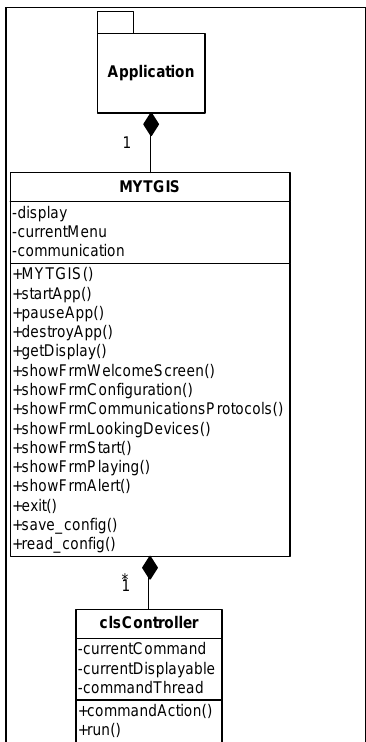
Figure 5. Class diagram of the graphic